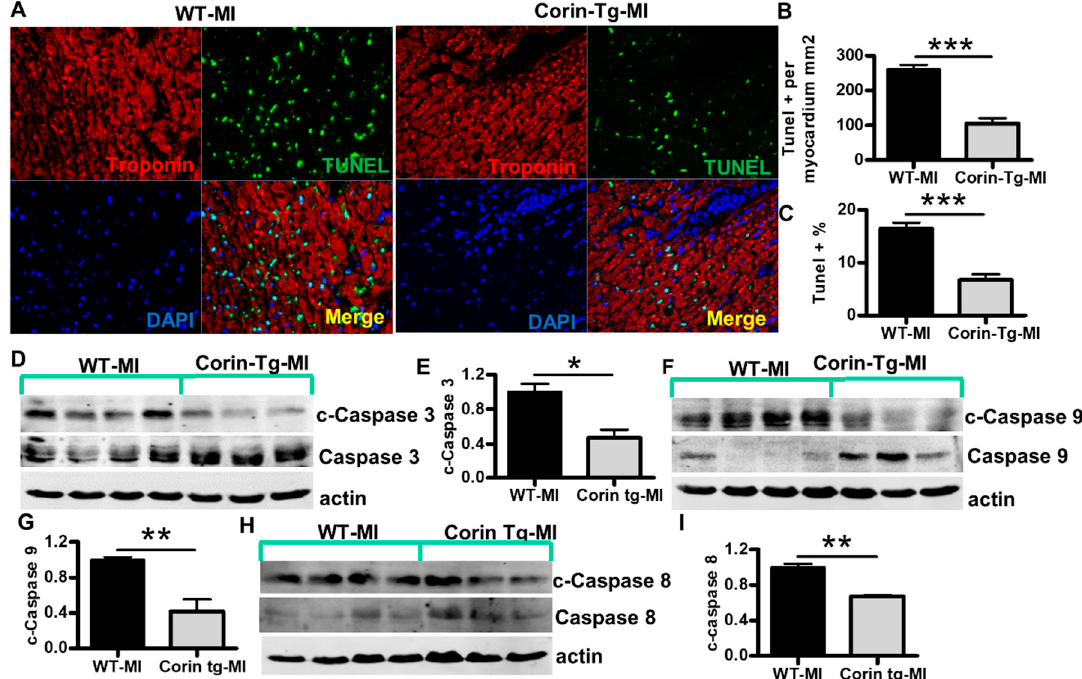
Figure 3. Cardiac-specific overexpression of corin attenuates cardiomyocyte apoptosis 24 hours post-MI. ( A ) Representative images of TUNEL staining (green) with troponin (red, cardiac marker) and DAPI-stained nuclei (blue) in the ischemic area of left ventricles (LV) from WT and corin-Tg mouse hearts post-MI (40 × magnification). ( B , C ) Quantitative digital analysis of TUNEL staining. The total numbers TUNEL-stained cells (TUNEL + ) and DAPI-stained nuclei (total cell) in the LV were counted; the total left ventricular area (LVA) was measured at 5 × using Image-Pro Plus software. The ratios of TUNEL + cells per myocardial area (mm2) and the percentages of TUNEL + cells vs. total cells were calculated. Data represent means ± SE of n = 4 mice per group. ( D , F , H ) Western blot analysis of tissue lysates, prepared using the infarct core and border zone myocardium from corin-Tg-MI ( n = 3) and WT-MI ( n = 4) hearts, with antibodies for cleaved (c) caspase 3 (17 kD), caspase 3 (34 kD) c-caspase 9 (37, 39 kD), caspase 9 (37 kD), c-caspase 8 (18 kD), and caspase 8 (55 kD) under reducing